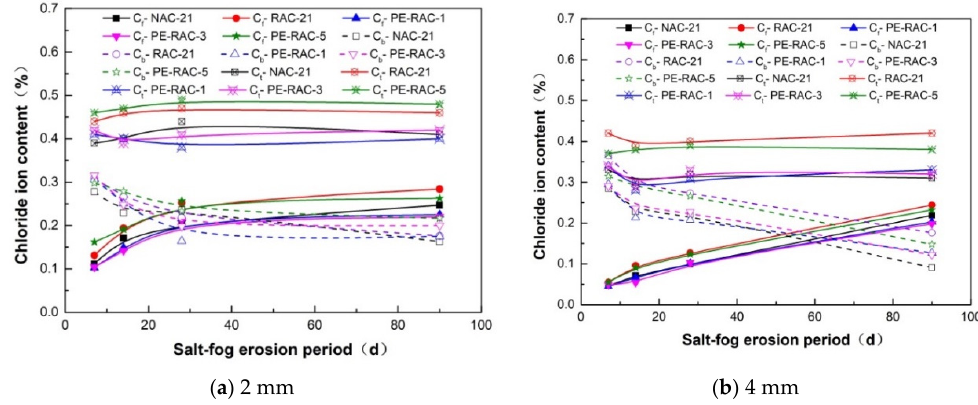
Figure 7. Distribution of ion concentration related to each age ( C f , C b , and C t ).